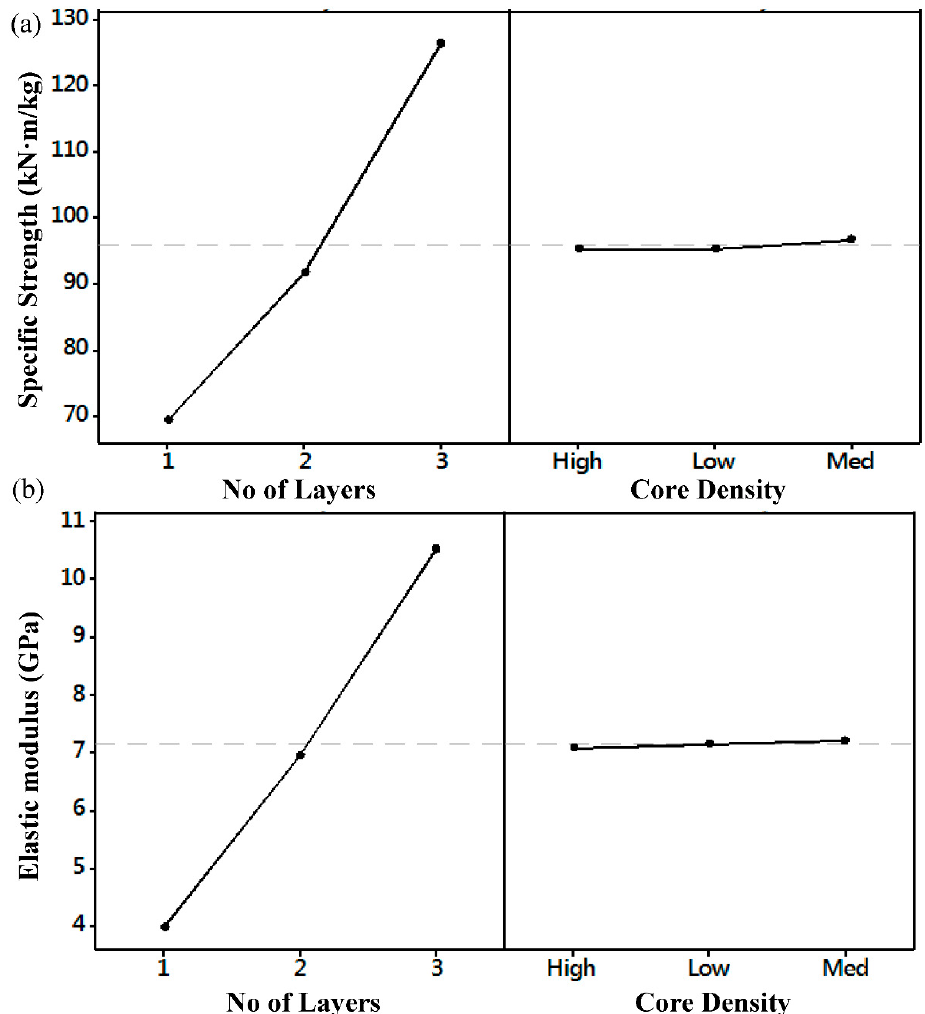
Figure 8. Effect of core density and number of CFRP layers on: ( a ) Specific strength; and ( b ) elastic modulus.